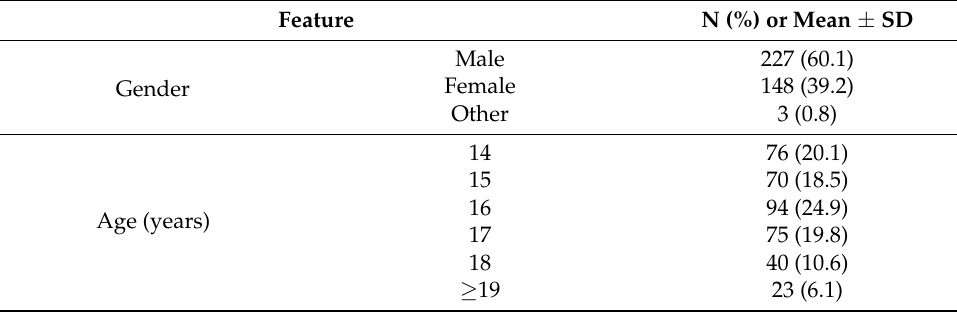
Table 1. Main sample demographic and anthropometric features ( n =